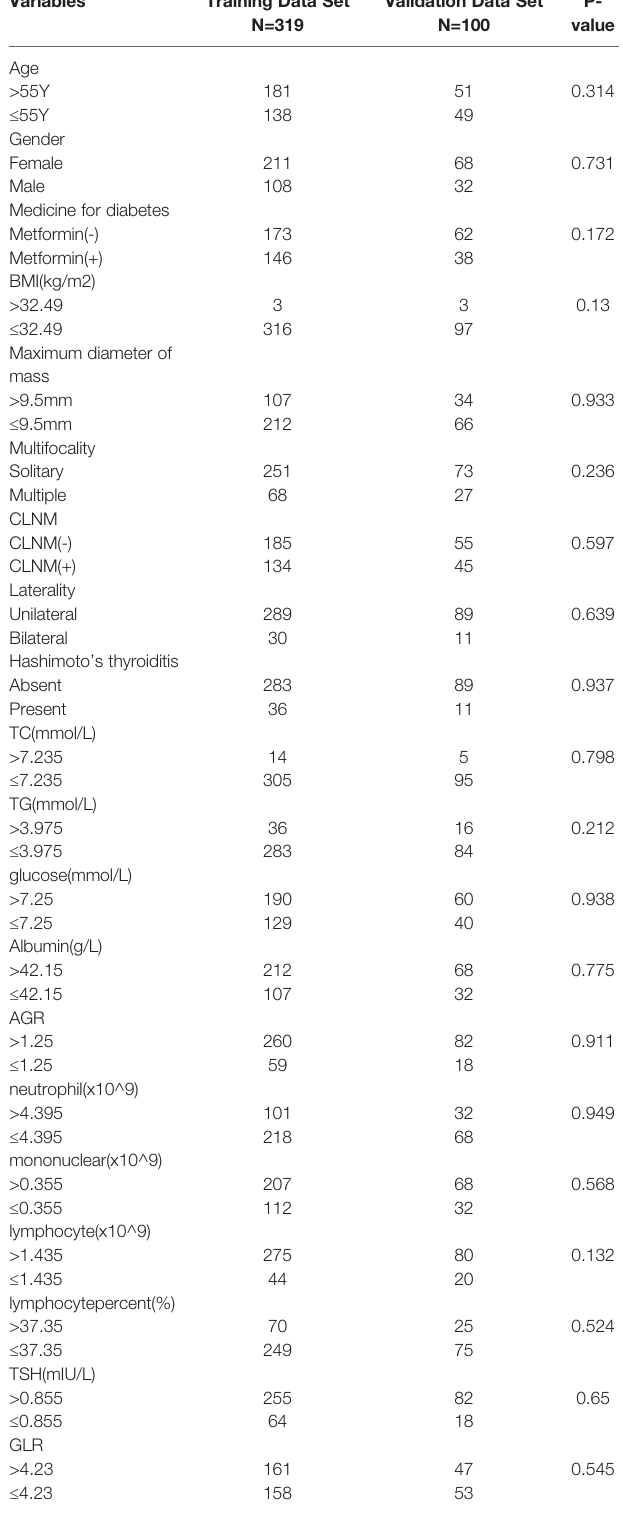
TABLE 1 | Baseline characteristics of patients in the training and external validation data